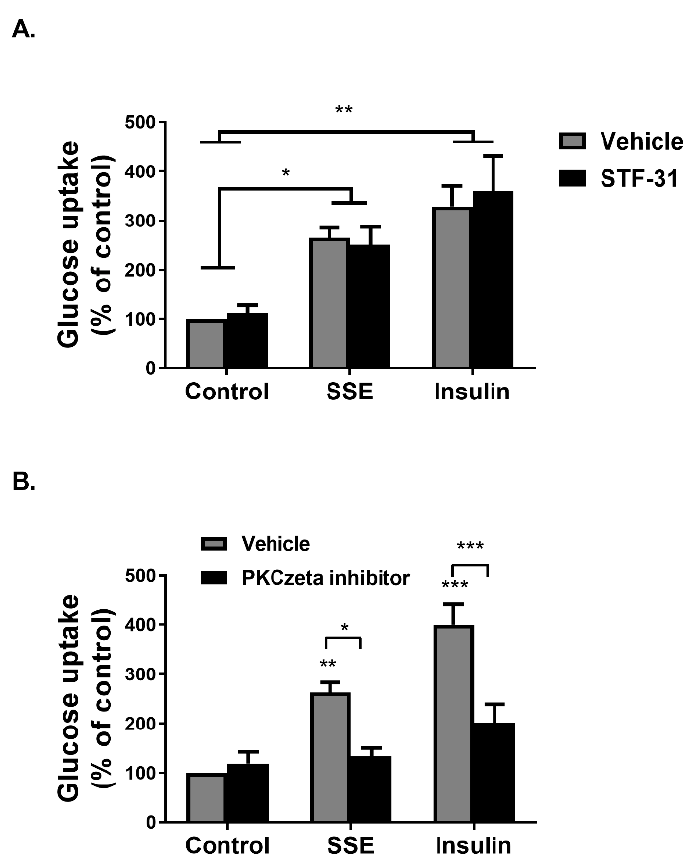
Figure 2. Induction of glucose uptake by SSE is facilitated by Glut4 transporters. ( A , B ) Di ff erentiated 3T3-L1 adipocytes were treated with 5 µ M STF31 for 1 h ( A ) or 50 µ M PKCzeta inhibitor ( B ) for 30 min before treatment with SSE or insulin for additional 30 min. Deoxy-D-glucose in cells was determined as described in Materials and Methods. Data are expressed as percent of basal uptake in control cells. The data represent the mean ± SEM of measurement made on six replicates in each of at least five independent experiments. * p < 0.05, ** p < 0.005, and *** p < 0.0005, analyzed by one-way ANOVA, followed by Bonferroni’s post-hoc testing.